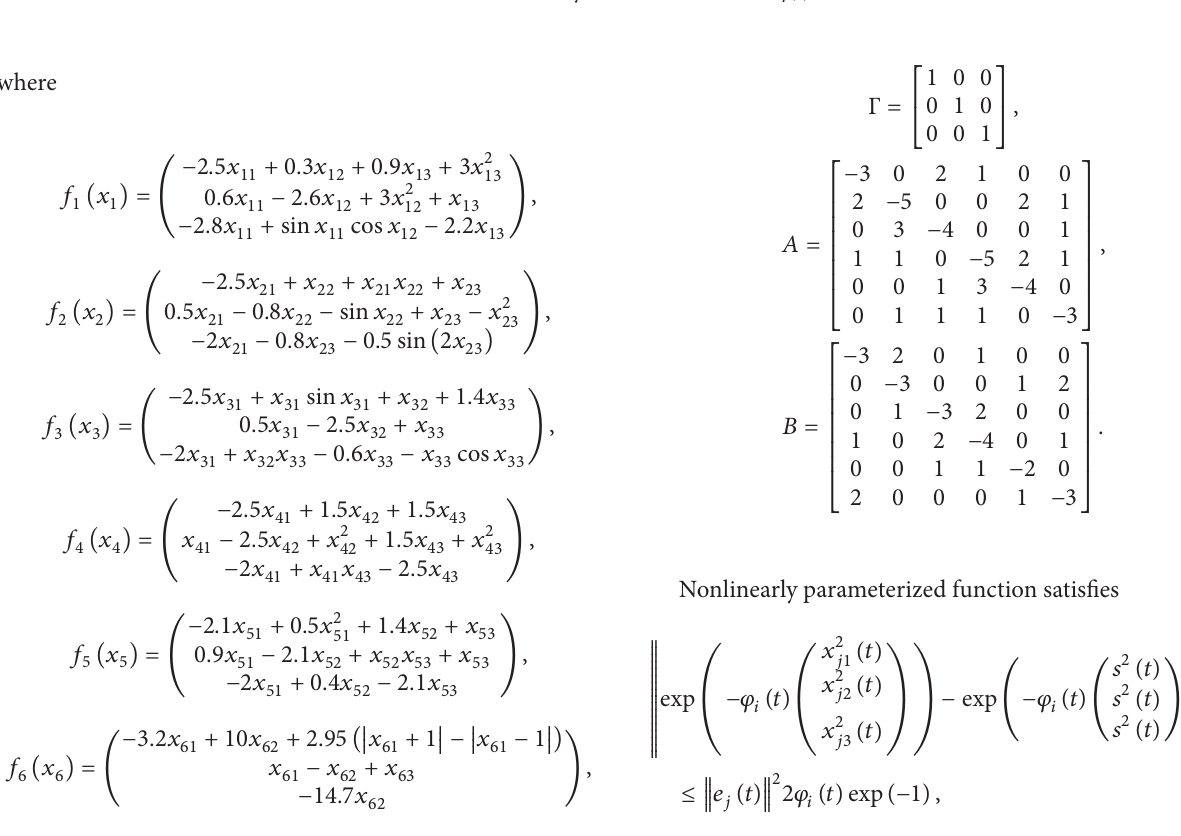
Figure 1: The evaluations of synchronization errors 𝑒 𝑖 (𝑡), 𝑖 = 1, . .. ,6